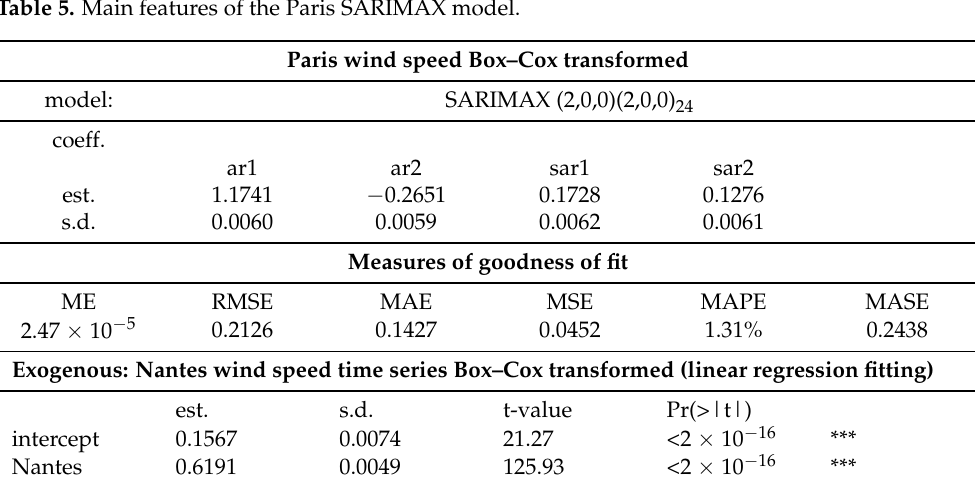
Table 5. Main features of the Paris SARIMAX